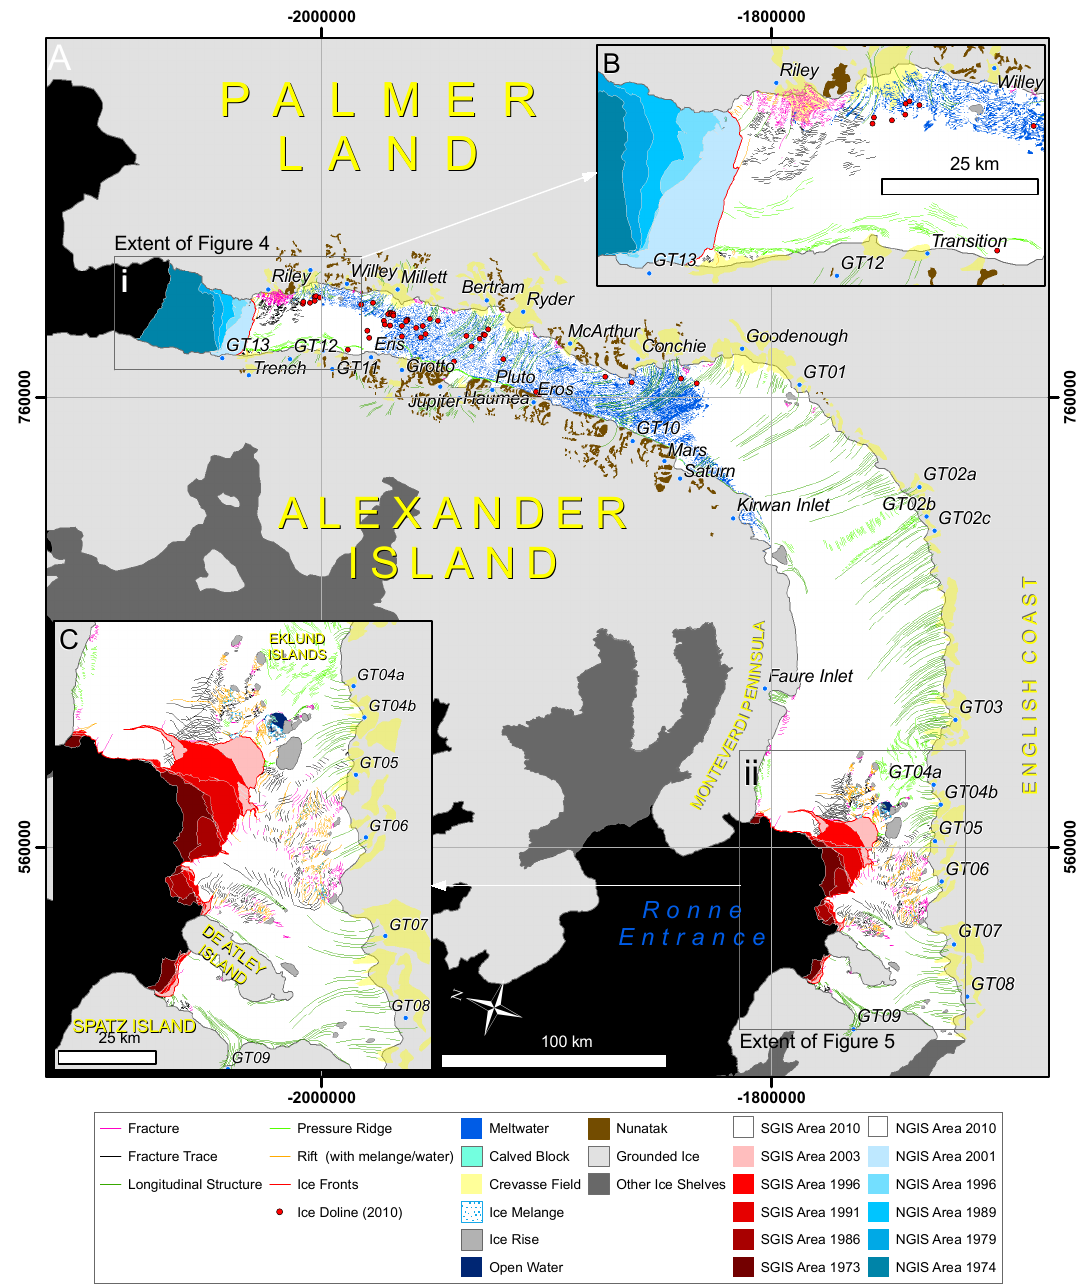
Fig. 2. (A) Glaciological structural overview (2010) illustrating the dominance of longitudinal structures, surface meltwater and rifts towards the south ice front (see Table 1 for a full list of identifying criteria and significance of ice-shelf structures and surface features). Retreat patterns of the northern (Ai, B ) and southern (Aii, C ) ice fronts are also illustrated: note in particular the large-scale breakup followed by more steady retreat at the north ice front and concentrated retreat in the central section of the south ice front between ca. 1973 and 2010.